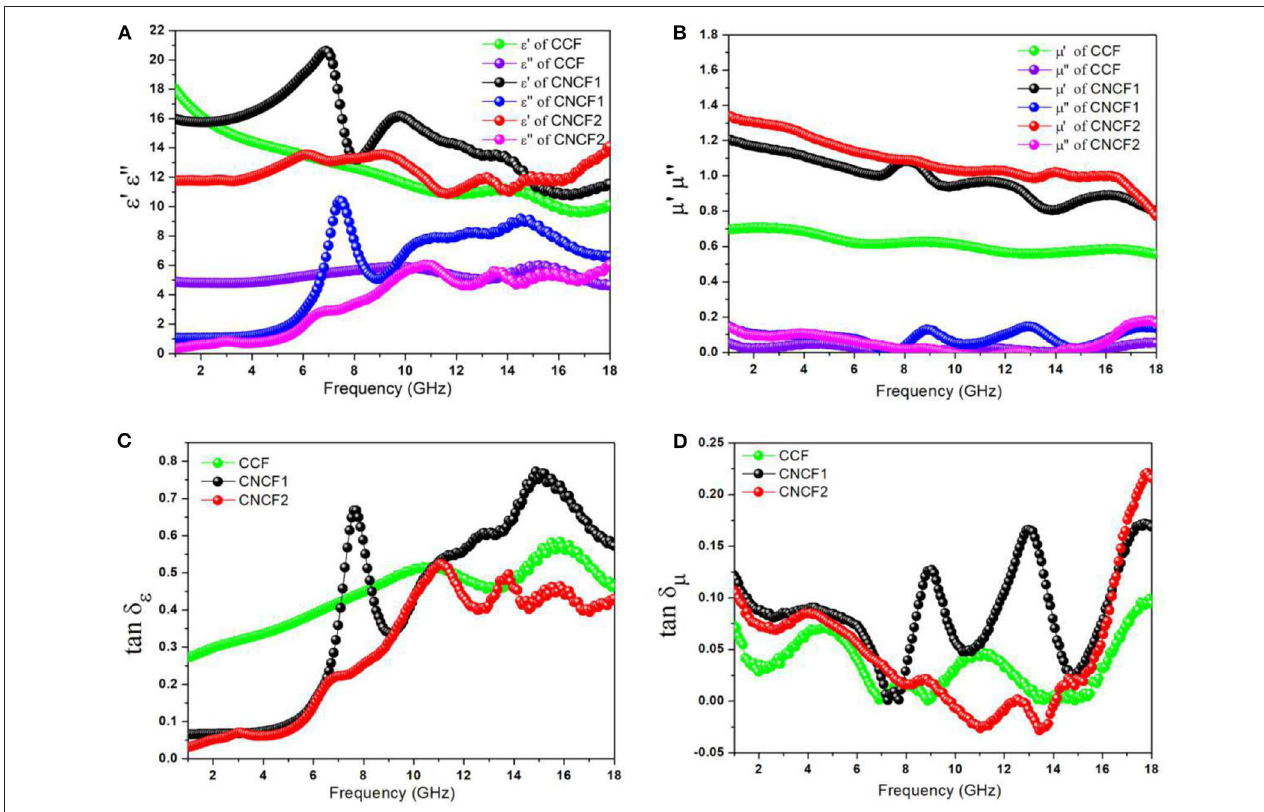
FIGURE 3 | Complex permittivity ( ε r ) (A) , complex permeability ( µ r ) (B) , dielectric dissipation factors (tan δ ε ) (C) , and magnetic dissipation factors (tan δ µ ) (D) of CCF and CNCF1-2 composites.